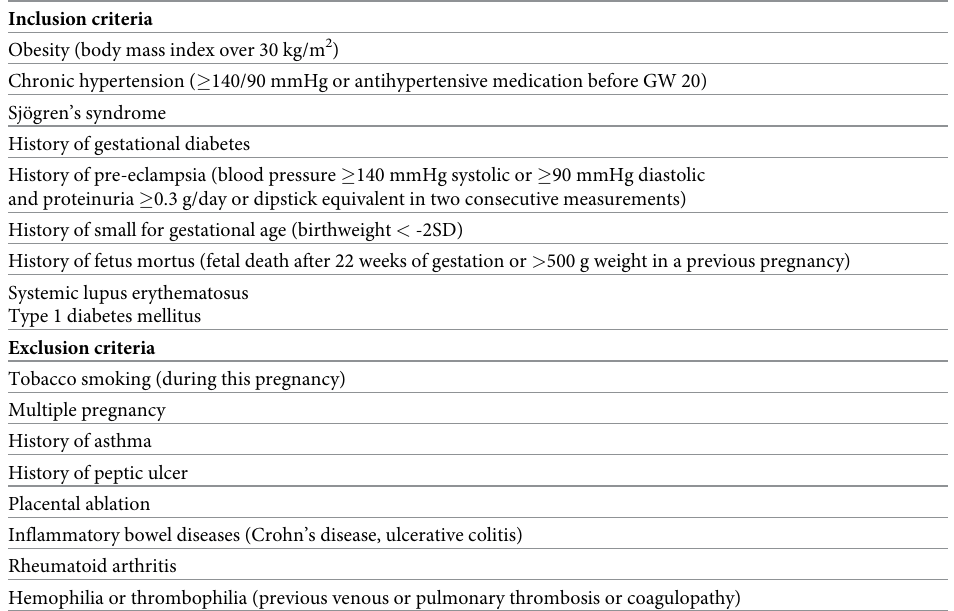
Table 1. Inclusion and exclusion criteria for high-risk women.